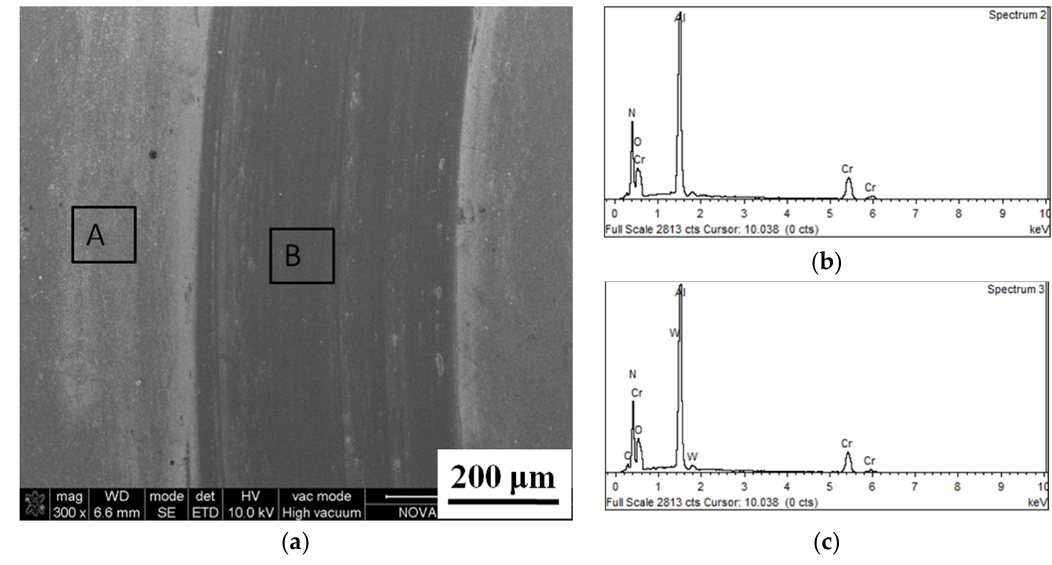
Figure 13. SEM image of wear track ( a ) and the corresponding energy-dispersive X-ray spectrometer (EDX) results of the intact surface in “A” ( b ) and the worn surface in “B” ( c ) on the AlCrN coatings deposited at 450 V charge voltage after the pin-on-disk wear tests at 800 °C.